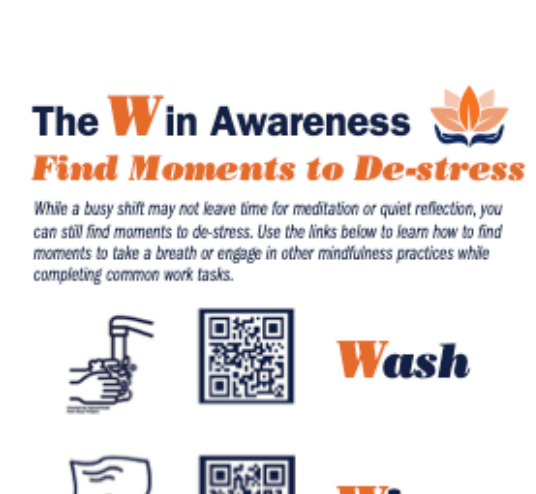
Figure 1. Mobile Toolbox with technology contents, Pocket Guide, and poster offerings.